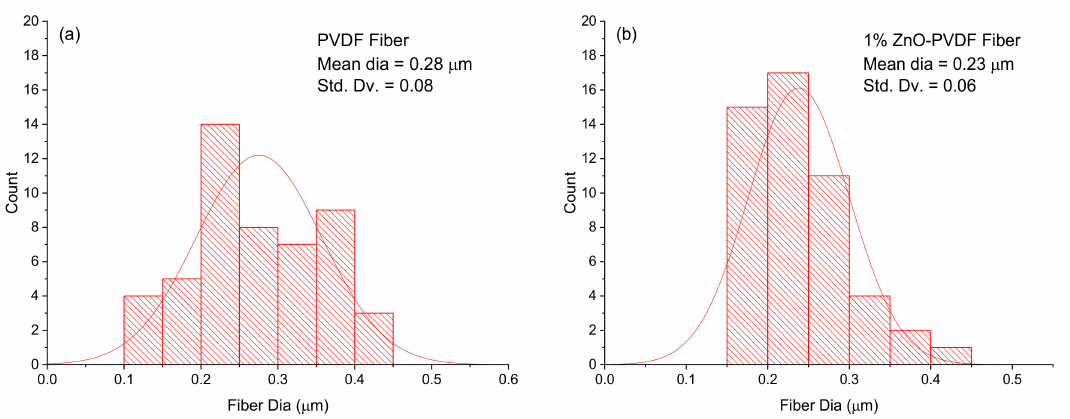
Figure 3. Fiber diameter distribution of the non woven textiles ( a ) PVDF, ( b ) 1% ZnO-PVDF, ( c ) 3% ZnO-PVDF and ( d ) 5% ZnO-PVDF fiber.